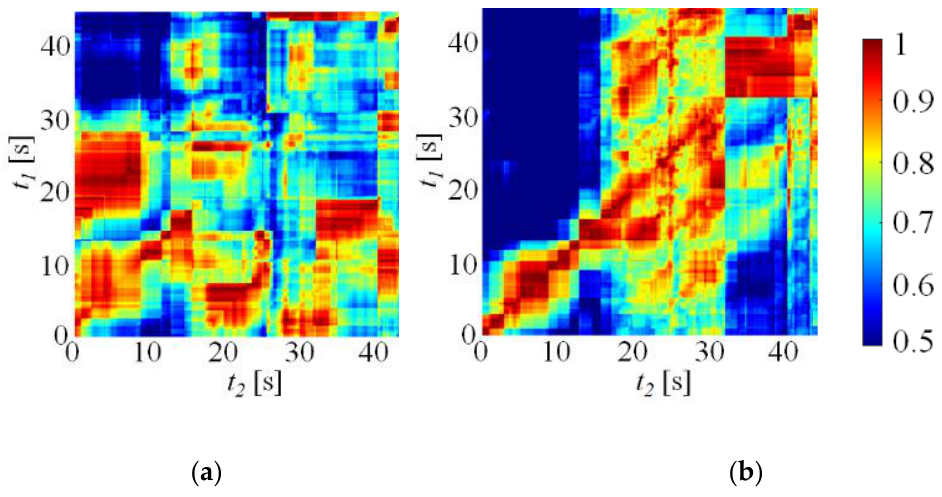
Figure 8. Cross-correlations of heat fluxes at two positions of Ch1 at Q ele = 2 W, ( a ) 1a and 1d, ( b ) 1c and 1d.